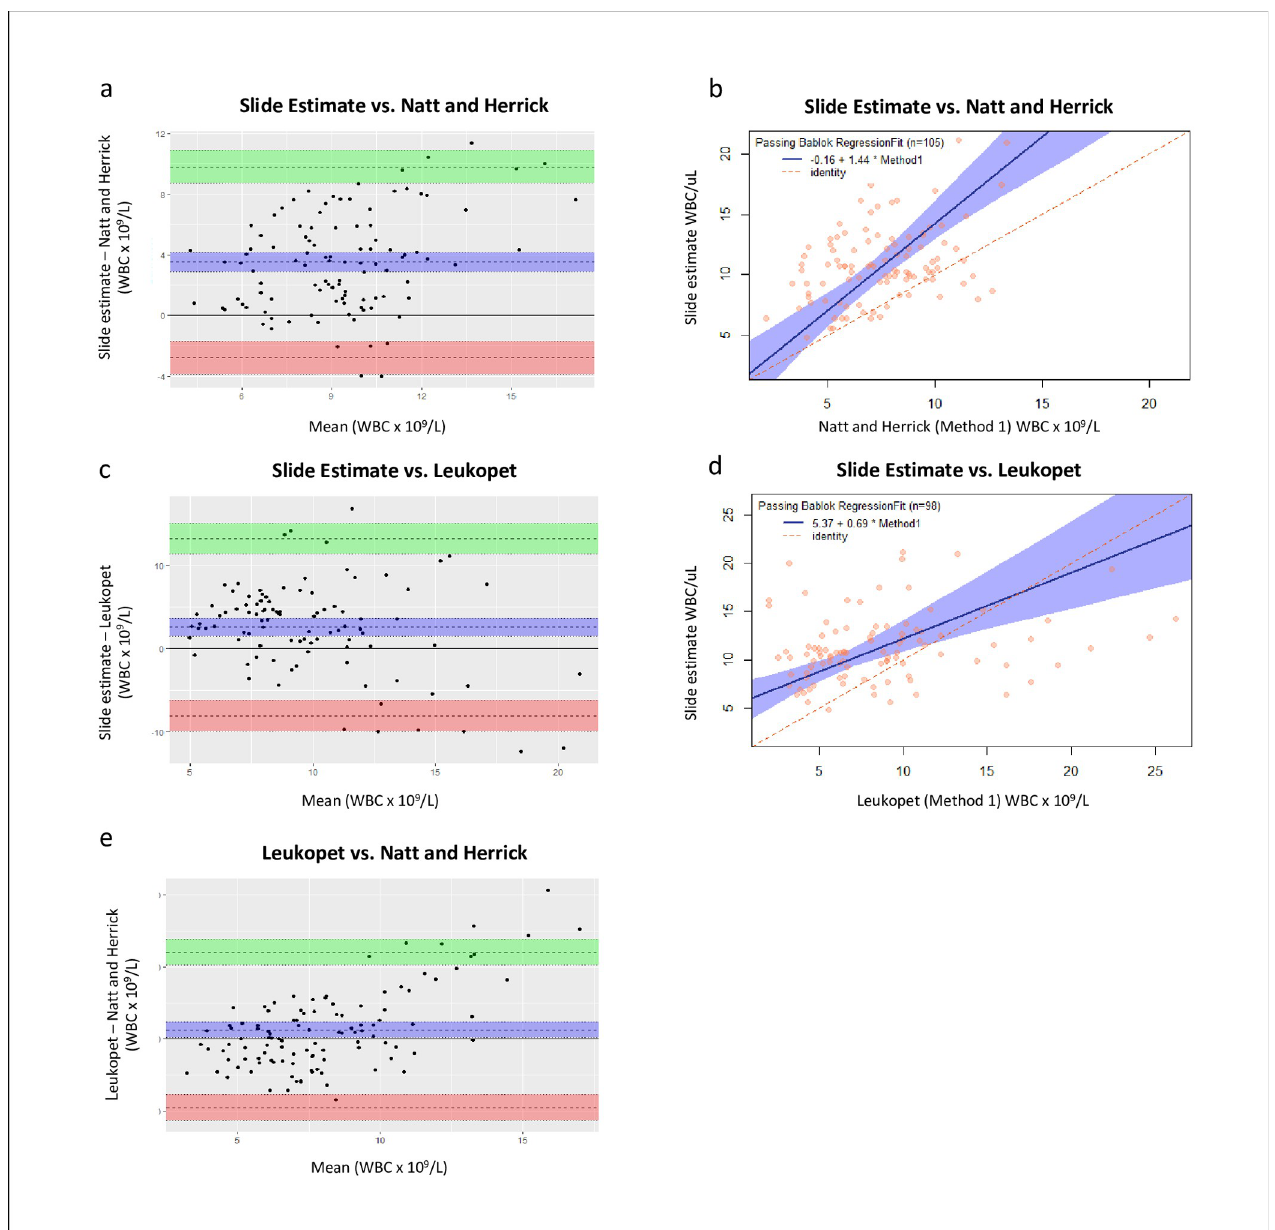
Fig 1. Agreement between WBC quantification methods in clinically healthy, subadult radiated tortoises. (a, c, e) Bland-Altman–solid line is the line of perfect agreement, dashed lines are mean difference between the methods (center), upper limit of agreement (upper), and lower limit of agreement (lower) with shading indicating associated 95% confidence intervals. (b, d) Passing-Bablok regression–dashed line is the line of perfect agreement, solid line is the regression line with shading indicating associated 95% confidence intervals. WBC = white blood